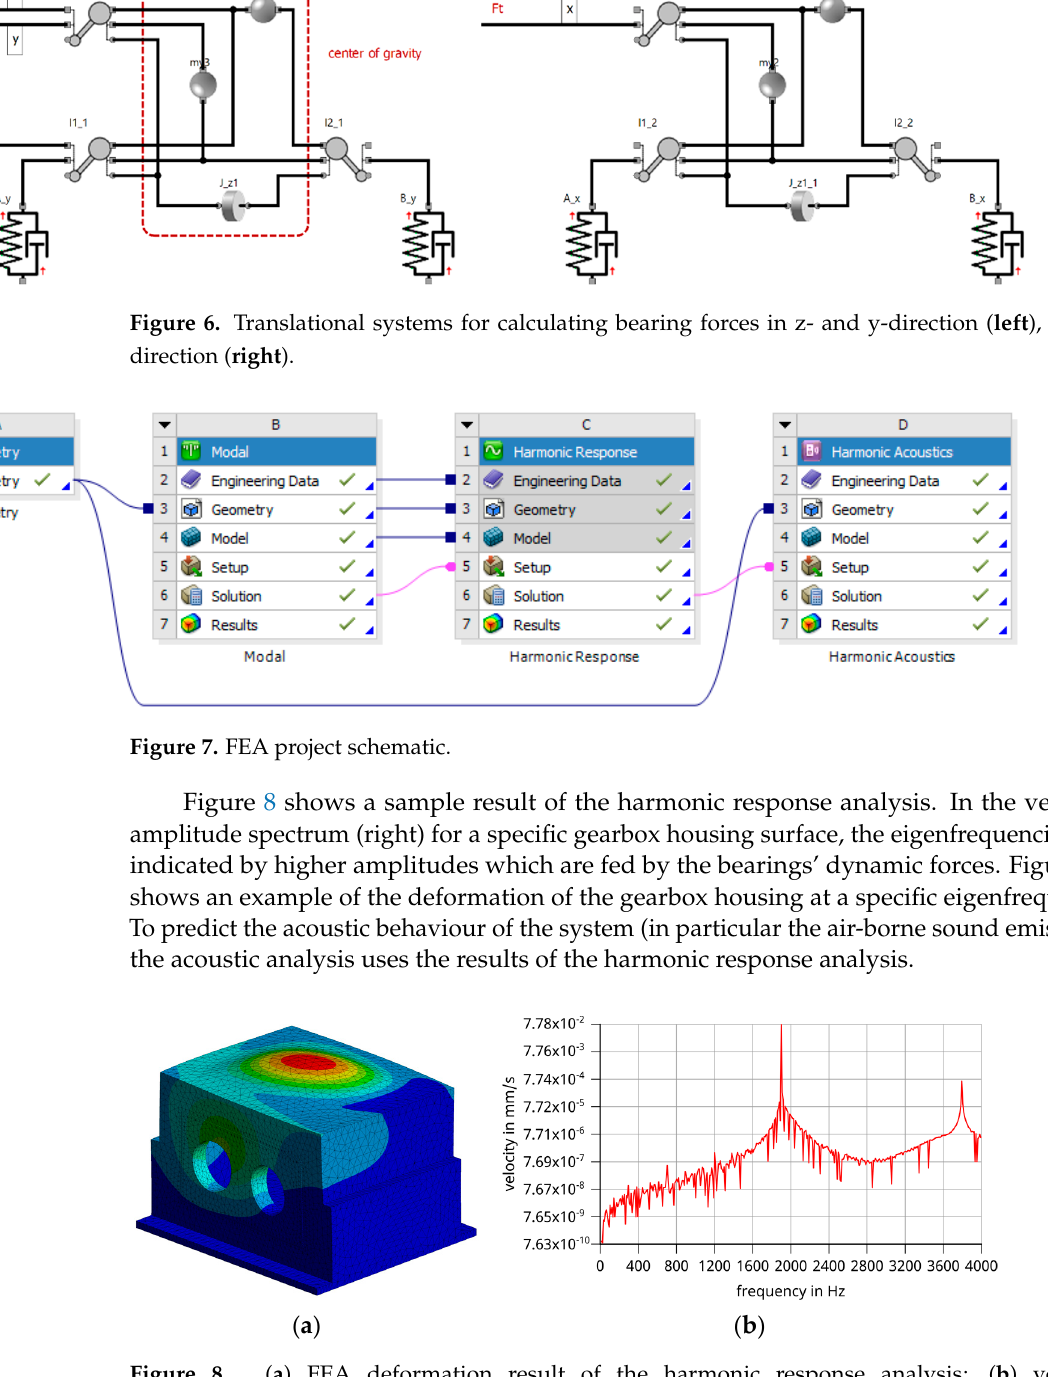
Figure 6. Translational systems for calculating bearing forces in z- and y-direction ( left ), and x-di- rection ( right ).